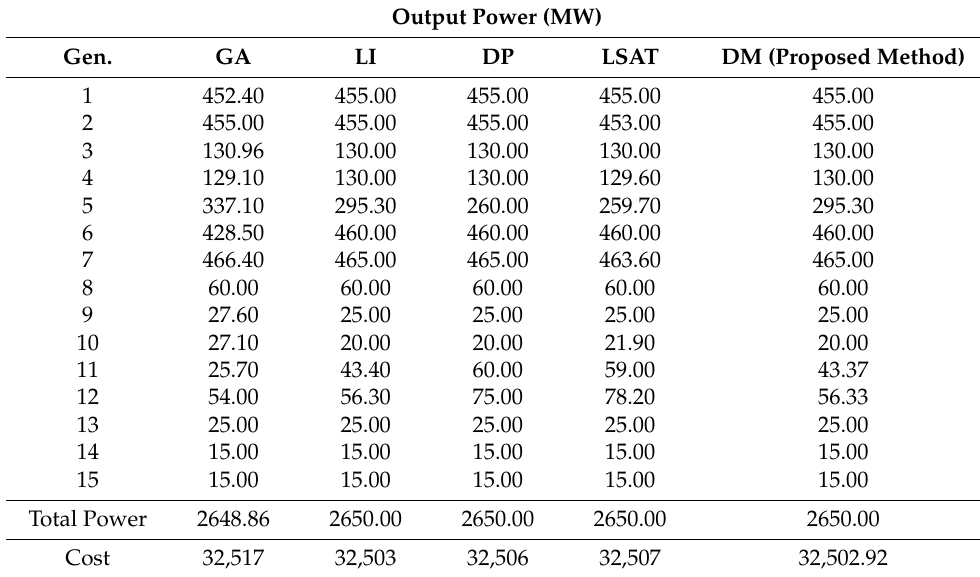
Table 1. Comparison of optimization